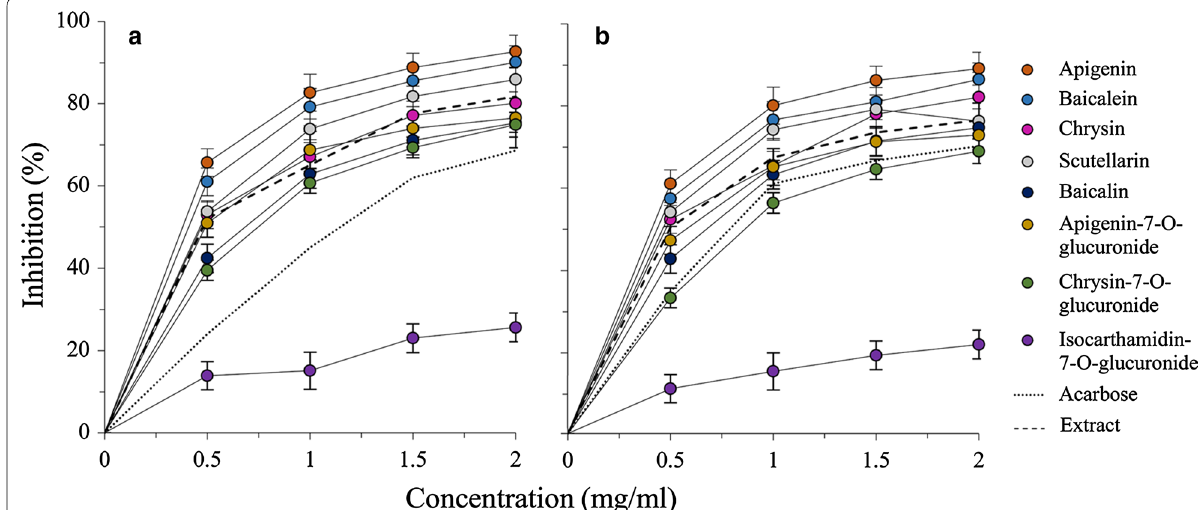
Fig. 2 Inhibitory effects of the eight high content flavonoids found in the flavonoids-rich extract of S. baicalensis shoots at different concentrations (0, 0.5, 1, 1.5, and 2 mg/mL) against α-glucosidase ( a ) and α-amylase ( b ). Dashed and dotted curves represents those inhibitory effects of acarbose and the flavonoids-rich extract in respective reproduced from Fig. 1. Results are presented as mean